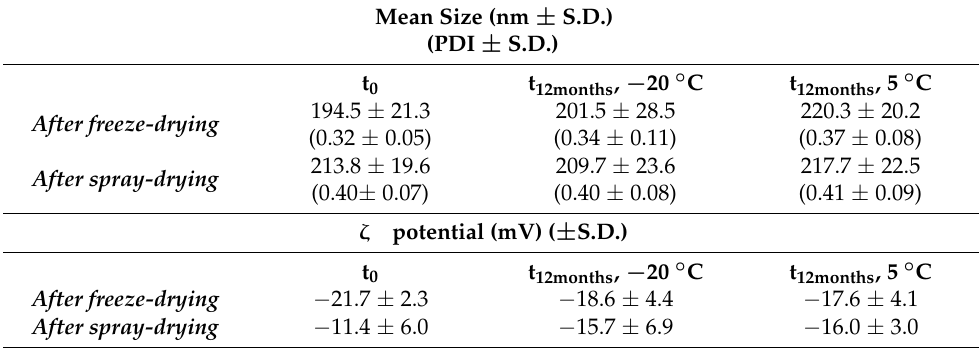
Table 5. Mean size, PDI and ζ potential values in bidistilled water of Man/Rapa-loaded KP-Nano, freshly freeze-dried or spray-dried ( t 0 ), and upon storage for 12 months at − 20 ◦ C (t 12months , − 20 ◦ C) or at 5 ◦ C (t 12months , 5 ◦ C). Mean Size (nm ± S.D.) (PDI ± S.D.) t 0 t 12months , − 20 ◦ C t 12months , 5 ◦ C 194.5 ± 21.3 201.5 ± (0.32 ± 0.05)